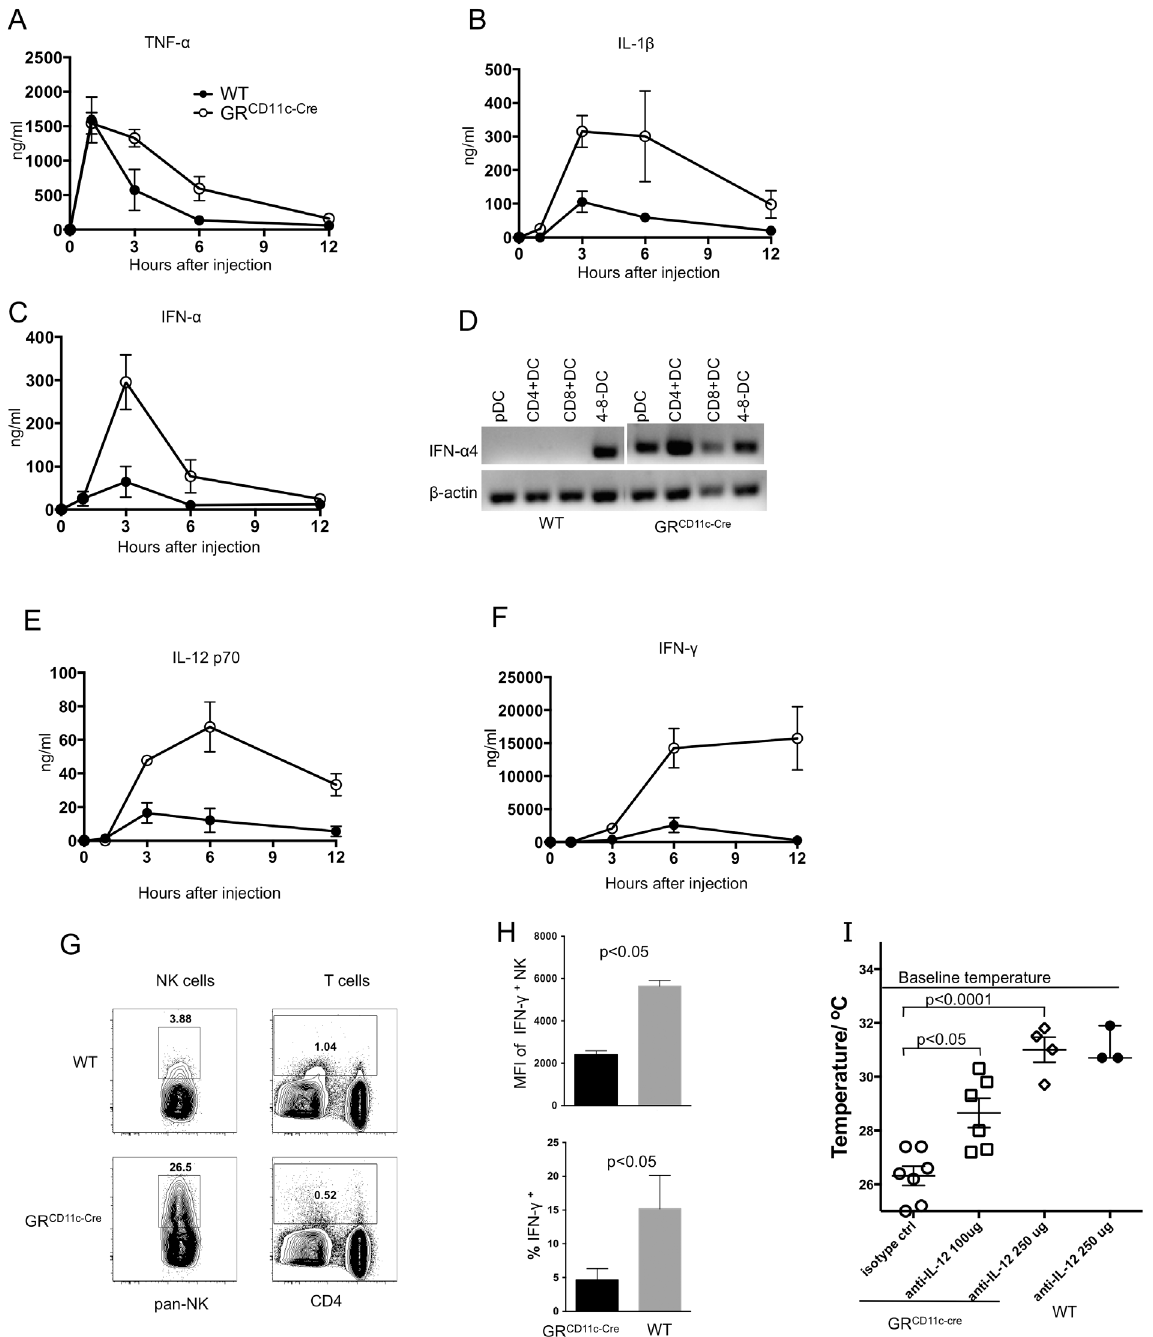
Fig 2. Elevated proinflammatory cytokines in GR CD11c-cre mice. (A – C, E, and F) Kinetics of LPS-induced cytokine levels in WT and GR CD11c-cre mice. The sera used in Fig 1C were also used to determine cytokine concentrations at each time point. Data shown are from four to eight animals per strain per time point pooled from multiple independent experiments. (D) Semiquantitative RT-PCR analysis of IFN- α 4 transcription in DC subsets from WT and GR CD11c-cre mice 1 hr after LPS challenge. β -actin was used as internal control. Results shown are one representative of two independent experiments with pooled splenocytes from two WT and two GR CD11c-cre mice. (G) Splenocytes were prepared from mice 12 hr after LPS injection, and cultured in vitro for 4 hr with Brefeldin A. Intracellular IFN- γ was measured for gated NK and T cells by flow cytometry. One mouse from each genotype is shown out of two independent experiments, each using three mice per group. (H) Mean fluorescence intensity (MFI) and percentage of IFN- γ + cells in WT and GR CD11c-cre mice 12 hr post LPS challenge ( n = 3). (I) GR CD11c-cre or WT mice, each represented by an individual symbol, were injected with the indicated doses of neutralizing anti-IL-12 antibody 1 hr before challenge with a lethal dose of LPS (10 μ g/g body weight). Surface body temperature at 30 hr is plotted. Results shown are pooled from two independent experiments, each with three to four mice per group. The data used to make this figure can be found in S1 Data.